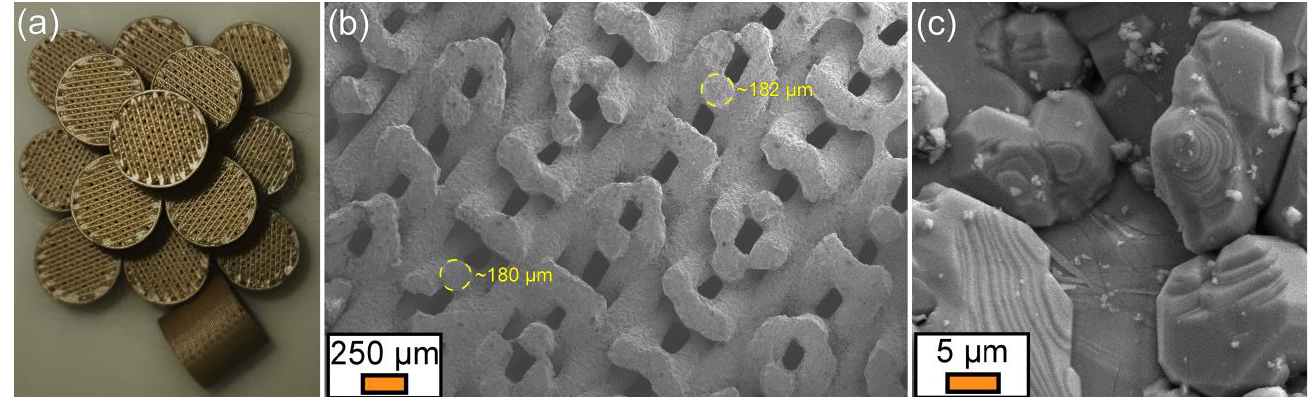
Figure 10. ( a ) Batch of sintered BCTZ50 scaffolds printed by robocasting. ( b ) General view of the filament arrangement and size, as evidenced by a low magnification FE-SEM image of a BCTZ50 scaffold fractured along its height. ( c ) Micro-structure of the sintered BCTZ50 filaments, as revealed by high-magnification FE-SEM analysis.